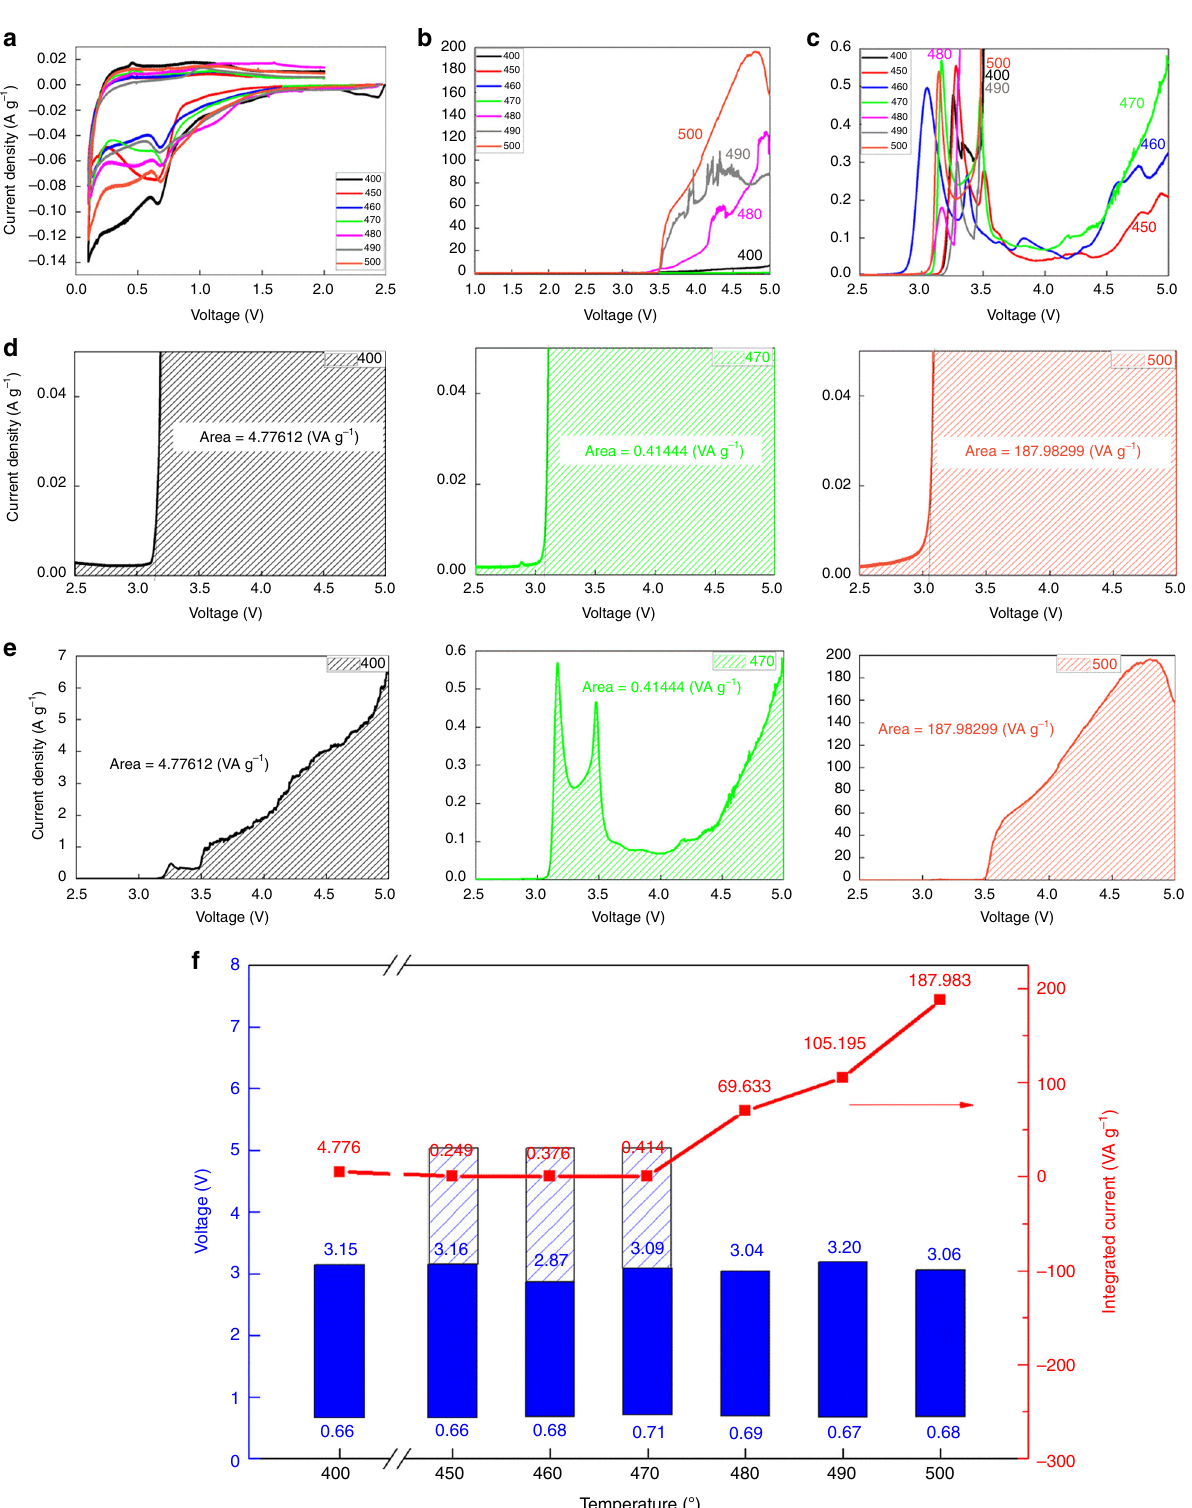
Fig. 3 Cyclic voltammetry (CV) test and analyses of the LSPS-Cl samples annealed at various temperatures. a Low-voltage (0.1 − 2.0 V) and b , c high- voltage (1.0 − 5.0 V) stabilities of LSPS-Cl materials. d Initial decomposition onset voltage and e integral spectrum intensity of three representative LSPS-Cl materials (LSPS-CL 400, 470, 500) in the categories of minor, medium, and severe decompositions. f Summary diagram to show the core-shell-structured LSPS-Cl materials with similar voltage stability window of ~0.7 – 3.1 V. The decomposition of minor-decomposition materials (LSPS-Cl 450 – 470) above 3.1